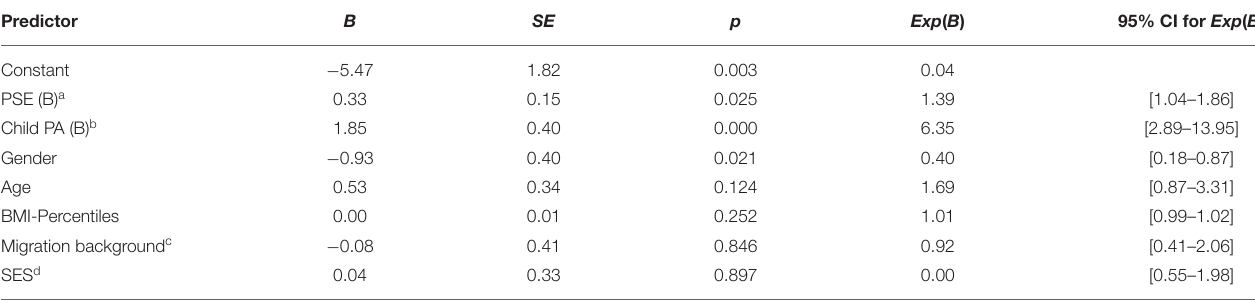
TABLE 2 | Parental self-efficacy at baseline as predictor of children’s physical activity at follow-up. Predictor